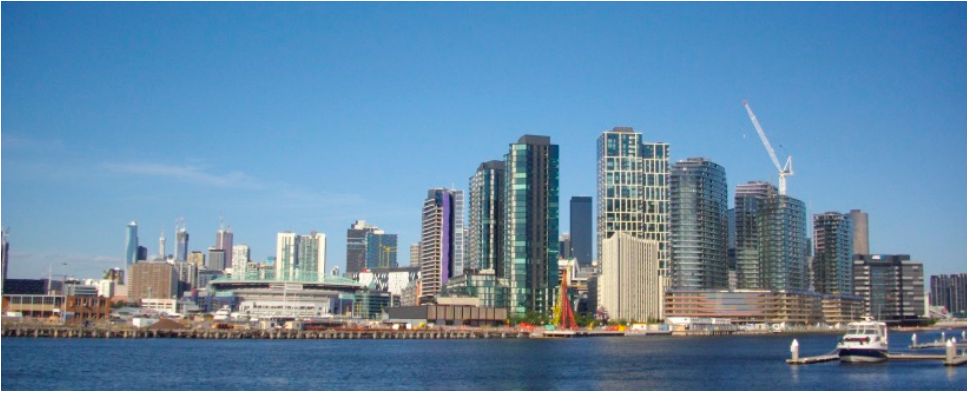
Figure 3. Central business district (CBD) development in Melbourne, Australia.